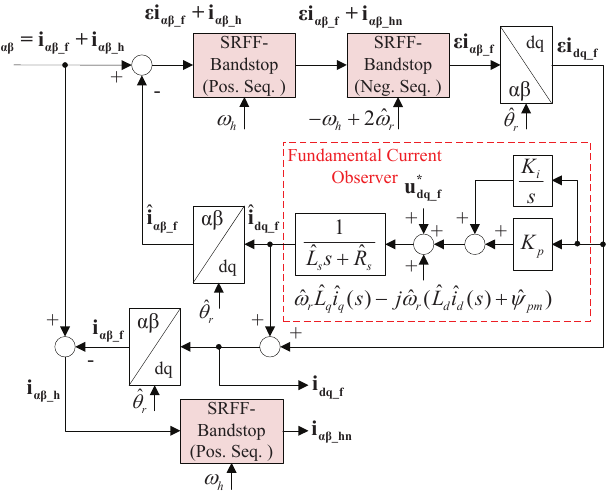
Figure 7. Total diagram of current-observer-based current filter used to separate the fundamental and negative-sequence currents.